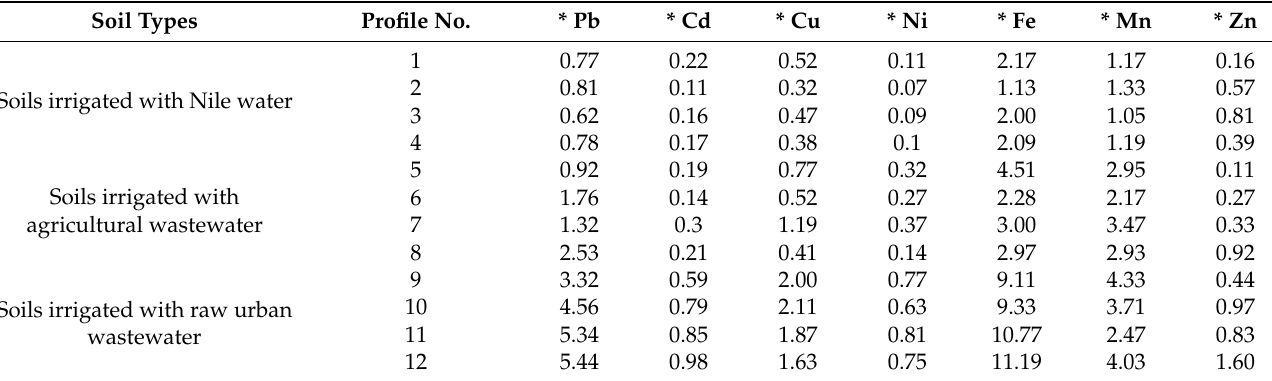
Table 2. Average soil heavy metals content (mg kg − 1 ) for the studied soil profiles. Soil Types Profile